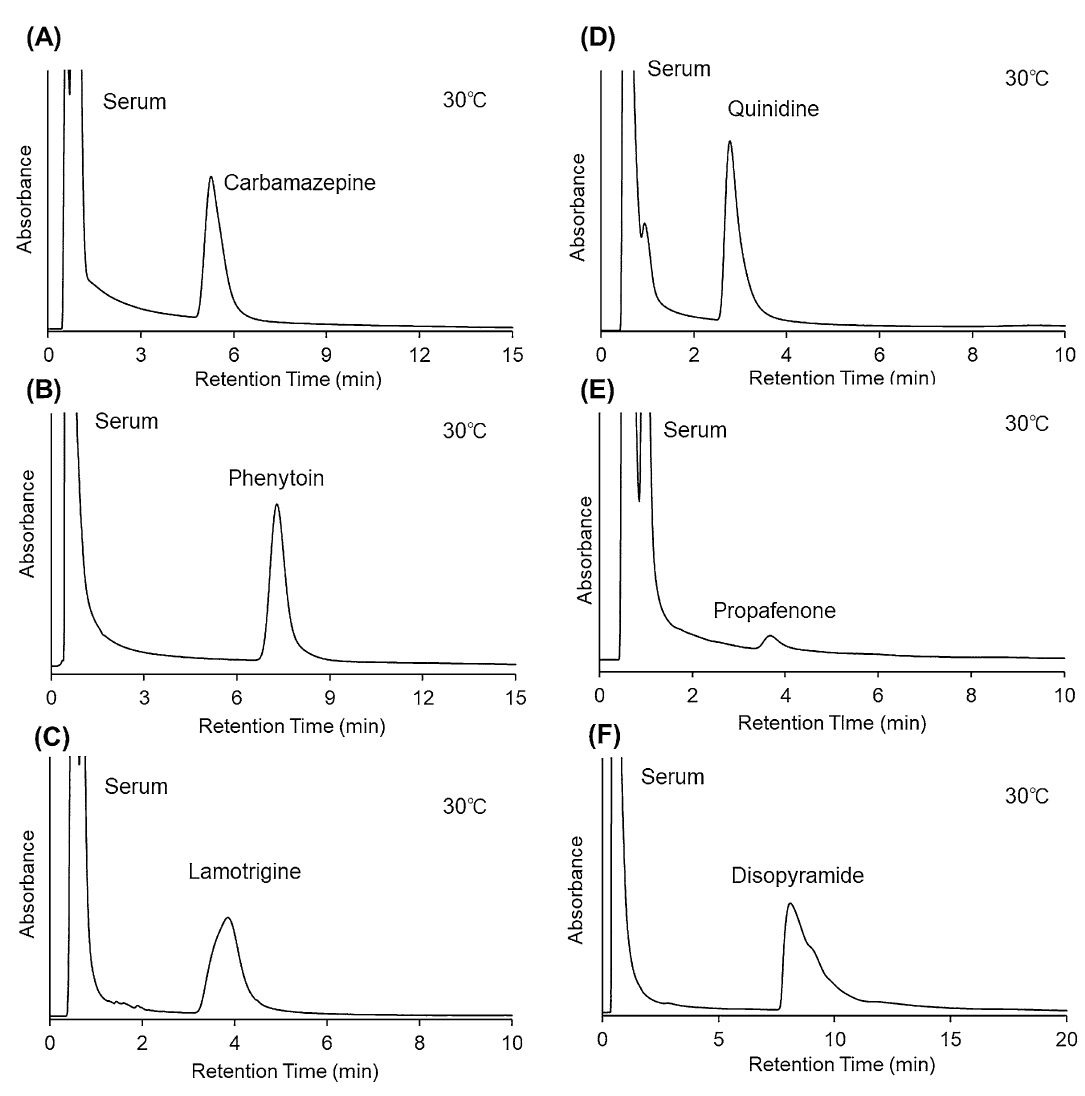
Figure 7. Chromatograms of antiepileptic drug and anti-arrhythmic drug with serum proteins using crosslinked PNIPAAm modified-bead packed columns. ( A ) Carbamazepine, ( B ) phenytoin, ( C ) lamotrigine, ( D ) quinidine, ( E ) propafenone, and ( F ) disopyramide. Mobile phase was 10 mM CH 3 COONH 4 (pH 6.75) buffer solution for carbamazepine, phenytoin, lamotrigine, and disopyramide, and 10 mM CH 3 COONH 4 buffer solution (pH 4.80) for quinidine and propafenone. The mobile phase flow rate was 1.0